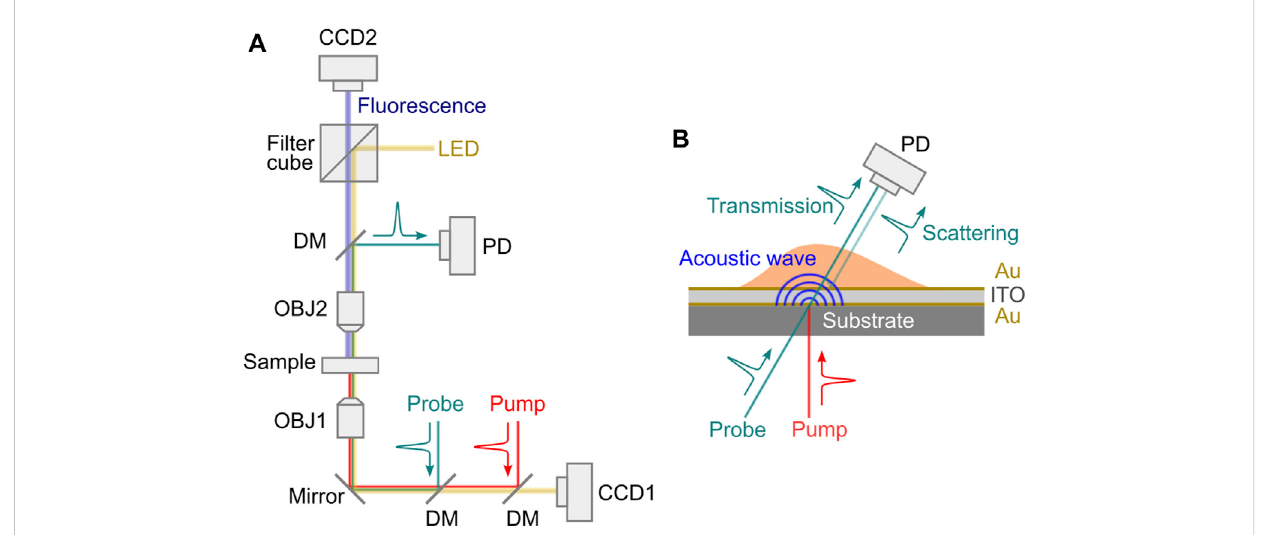
FIGURE 6 Schematic of laser-induced picosecond ultrasonics setup. (A) Representative optical setup. LED: light emitting diode; DM: dichroic mirror; OBJ1- OBJ2: objective lens; PD: photodetector. (B) Transducer